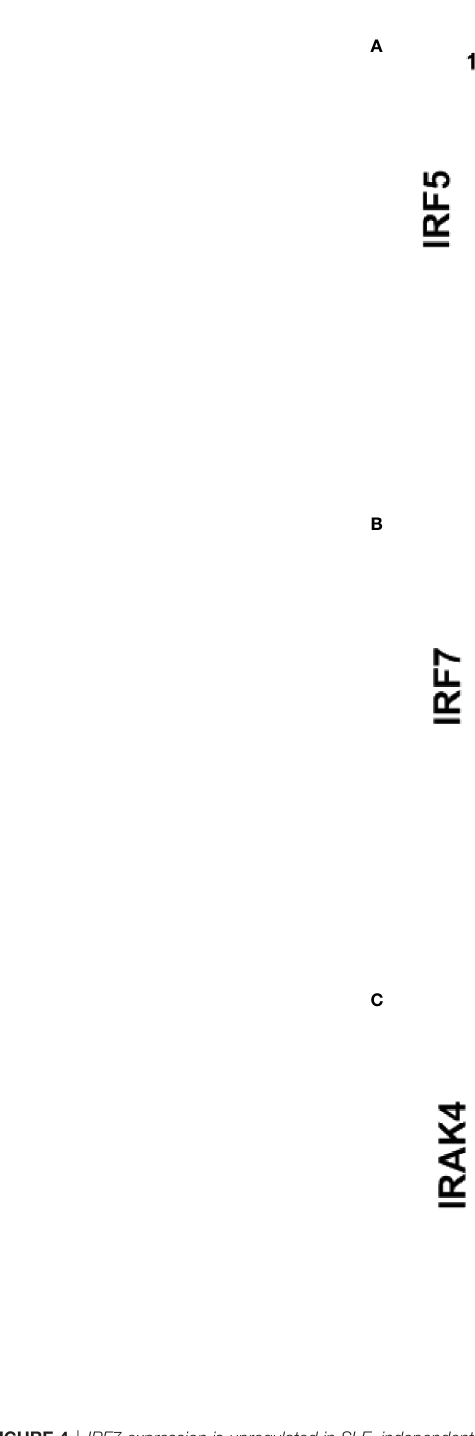
FIGURE 4 | IRF7 expression is upregulated in SLE, independent of pDC expression. RNA was isolated from paxgene blood samples and RT-PCR was run using Taqman probes for signaling molecules within the TLR activation pathway: (A) IRF5 , (B) IRF7 , and (C) IRAK4 . A single HC male sample was set as the standard level of expression and all samples were quanti fi ed as the relative gene expression to this control. Each sample was then normalized to its %pDCs as determined by fl ow cytometry analysis as presented in Figure 1B . Comparisons were made using Kruskal-Wallis Test with Dunn ’ s test for multiple comparisons. Bars represent median and interquartile range. aSLE F (N = 15), iSLE F (N = 50), HC F (N = 14), aSLE M (N = 5), iSLE M (N = 6), HC M (N = 5). *p < 0.05; **p <